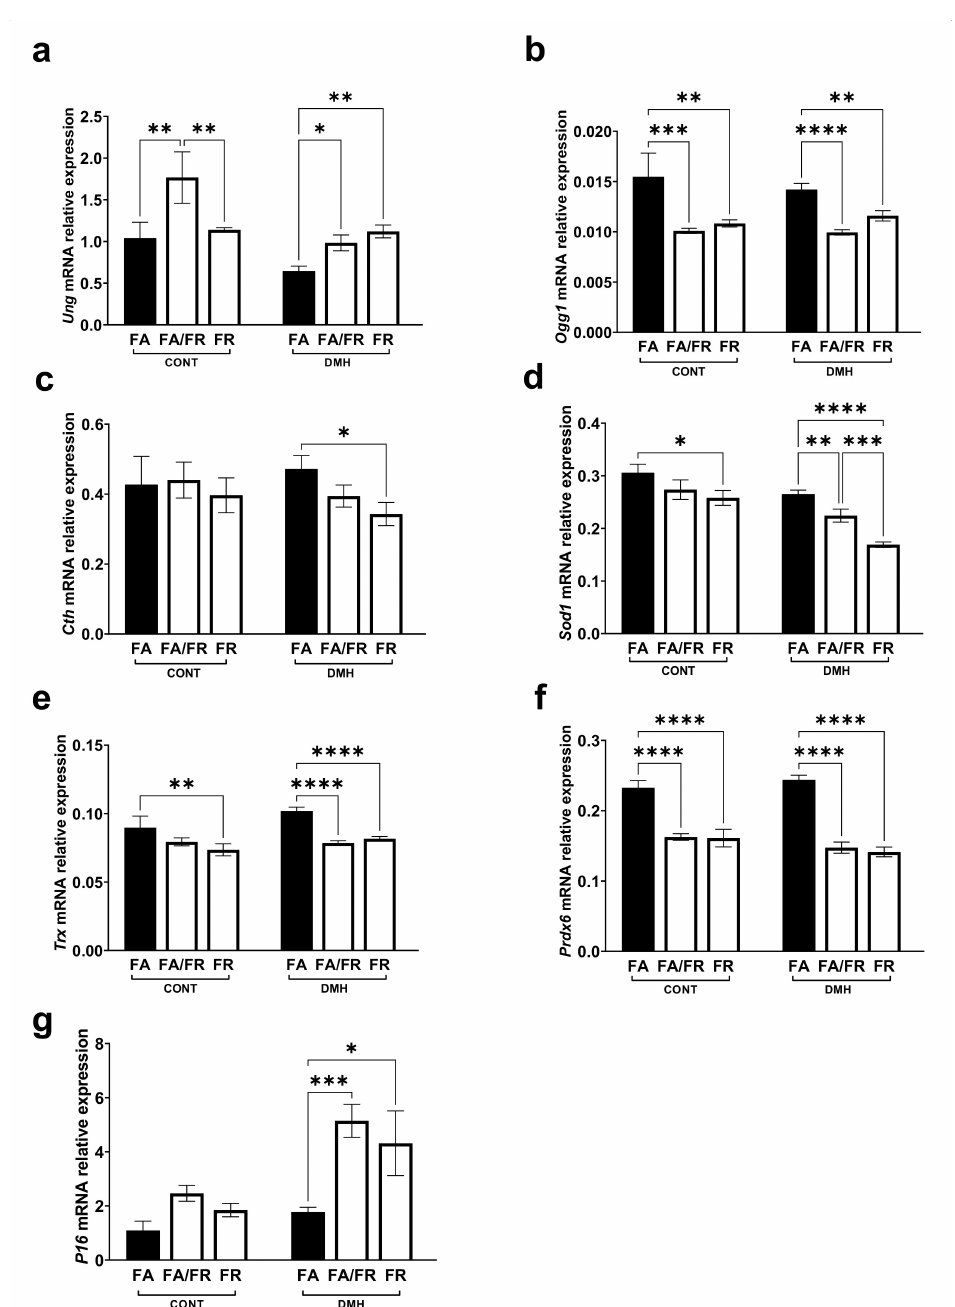
Figure 5. Effect of the timing and duration of folate restriction on relative expression of genes known to be altered by folate status and oxidative stress in the liver of untreated controls (CONT) and dimethylhydrazine treated (DMH) c57BL/6 mice. ( a , b ) mRNA relative expression of uracil DNA glycosylase ( Ung ) and 8-oxoguanine DNA glycosylase ( Ogg1 ). ( c ) mRNA relative expression of cystathionine- γ -lyase ( Cth ). ( d–f ) mRNA relative expression of the antioxidant genes superoxide dismutase ( Sod1 ), thioredoxin ( Trx ), and peroxiredoxin ( Prdx6 ). ( g ) mRNA relative expression of the tumor suppressor P16 ink4a . FA = folate adequate diet, FA/FR = folate adequate diet followed by initiation of folate-restricted diet one week prior to DMH injections, FR = folate-restricted diet, CONT = untreated control mice, n = 3; DMH = mice treated with the liver/colon carcinogen dimethylhy- drazine, n = 6–7. Real-time data were normalized to geometric mean of Gapdh and Rplp0 . Bars, S.E.M, * p < 0.05, ** p < 0.005, *** p < 0.001, **** p <